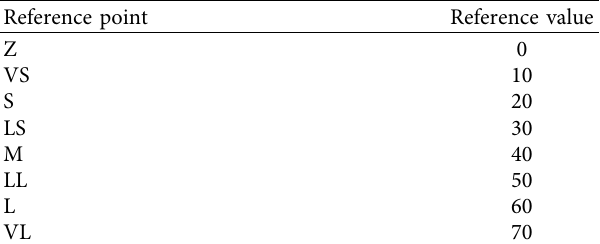
Table 1: Reference points and reference values for x